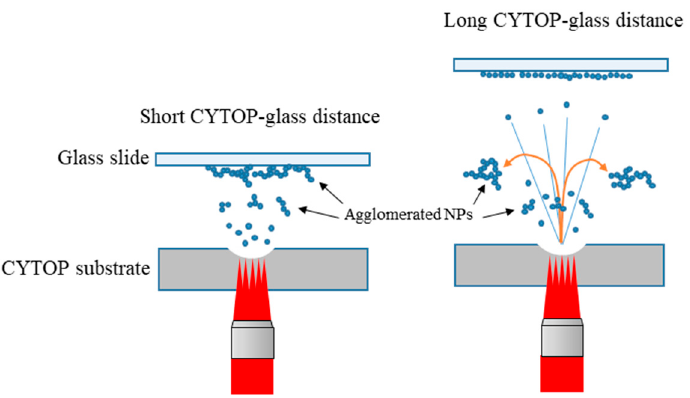
Figure 10. Schematics of the NP deposition via CYTOP ablation, where the deposited structure is dependent on the CYTOP–glass distance.